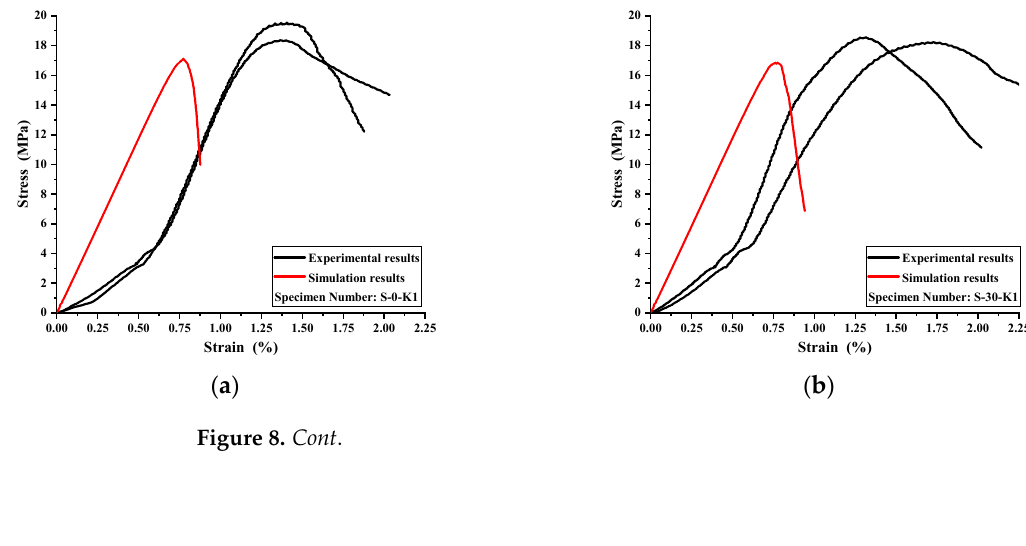
Figure 7. Typical failure pattern in jointed specimens.